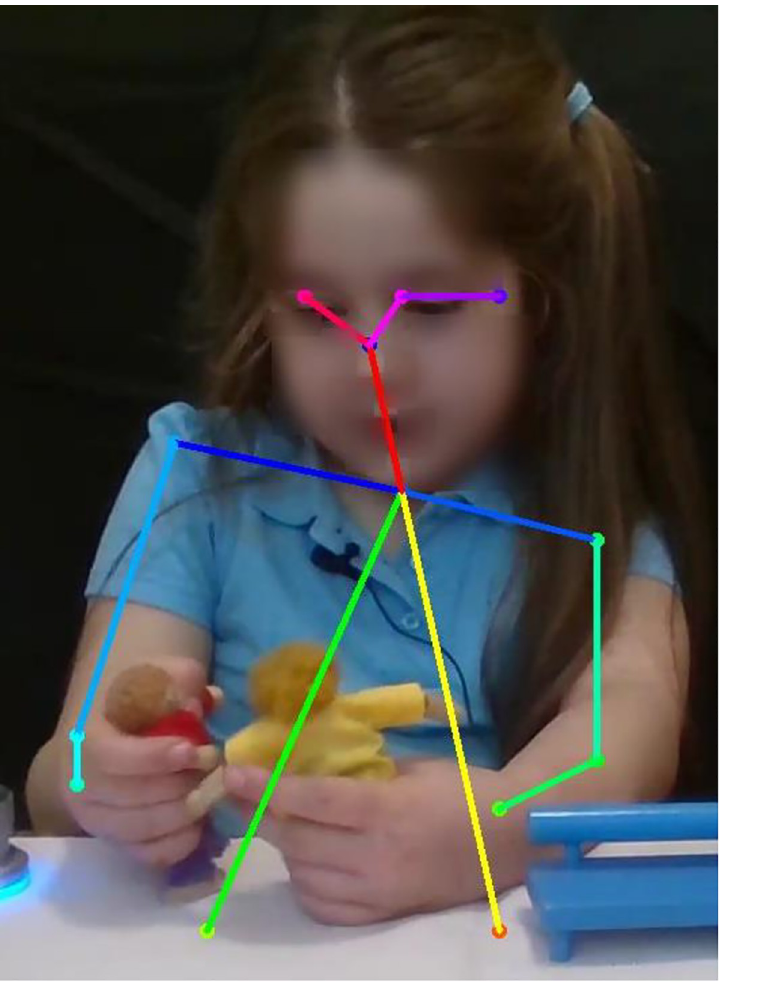
Fig 4. Production of a generic frame in a video using OpenPose